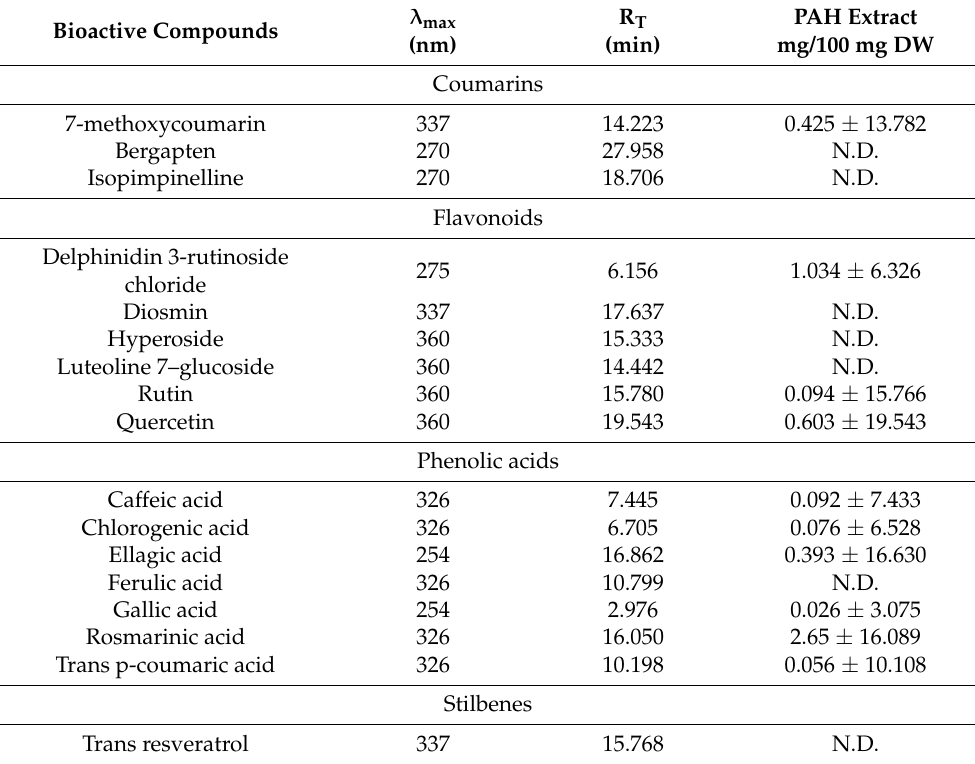
Table 2. The contents in the phenolic compounds measured in the PAH